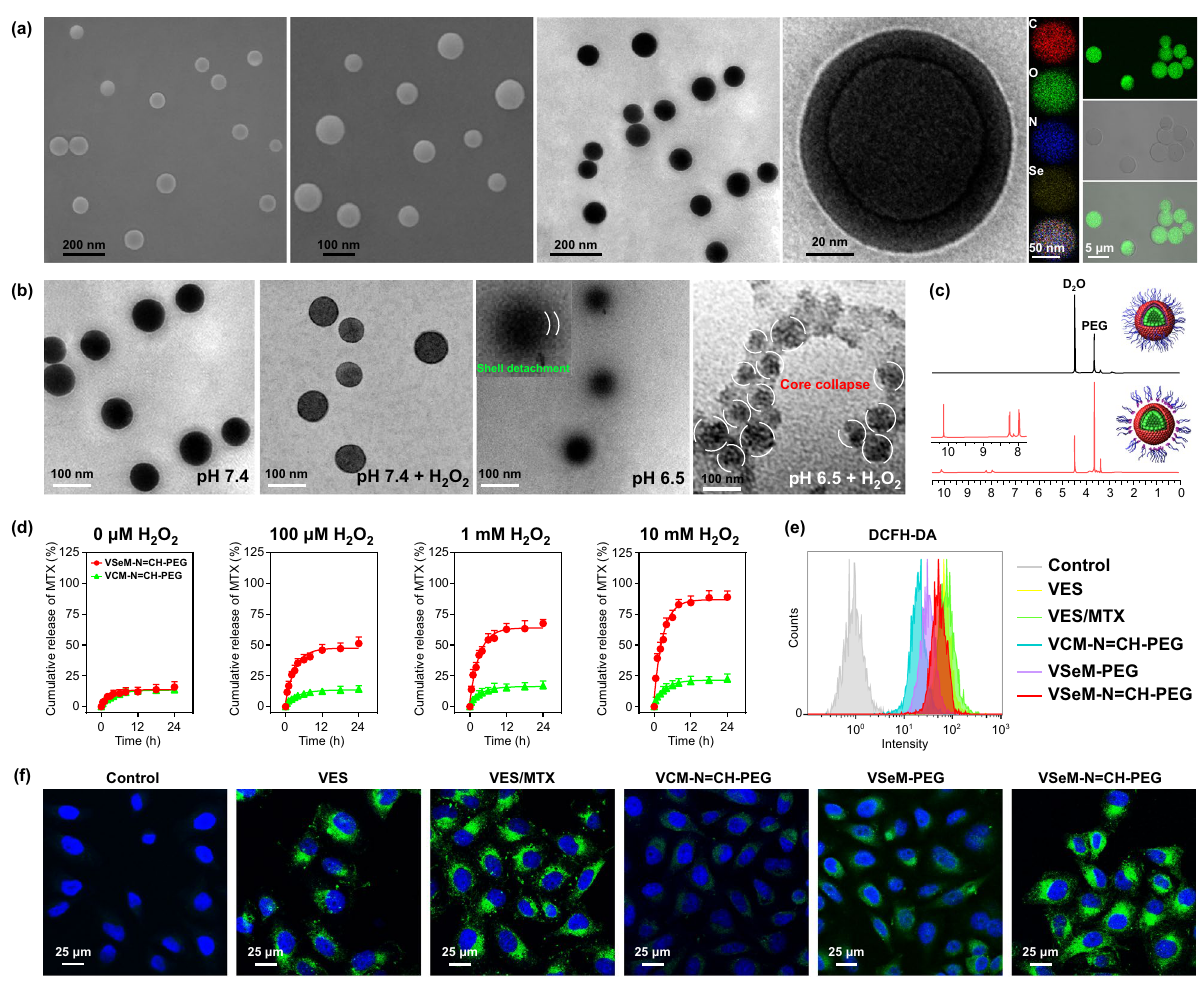
Fig. 1 Characterization of VSeM-N=CH-PEG. a SEM, TEM, element mapping, and CLSM images of VSeM-N=CH-PEG nano-prodrug. b TEM images of VSeM-N=CH-PEG nano-prodrug at pH 7.4 and 6.5 without or with H 2 O 2 (1 mM) for 0.5 h (pH 6.5) and 2 h (pH 7.4). c 1 H NMR analysis of VSeM-N=CH-PEG nano-prodrug at pH 7.4 and 6.5. d Cumulative release of MTX from VSeM-N=CH-PEG at pH 6.5 with various concentrations of H 2 O 2 . e Flow cytometry profiles and f CLSM images of ROS levels in HeLa cells treated with VES/MTX, VCM- N=CH-PEG, VSeM-PEG, and VSeM-N=CH-PEG at pH 6.5 for 6 h. ROS was stained with